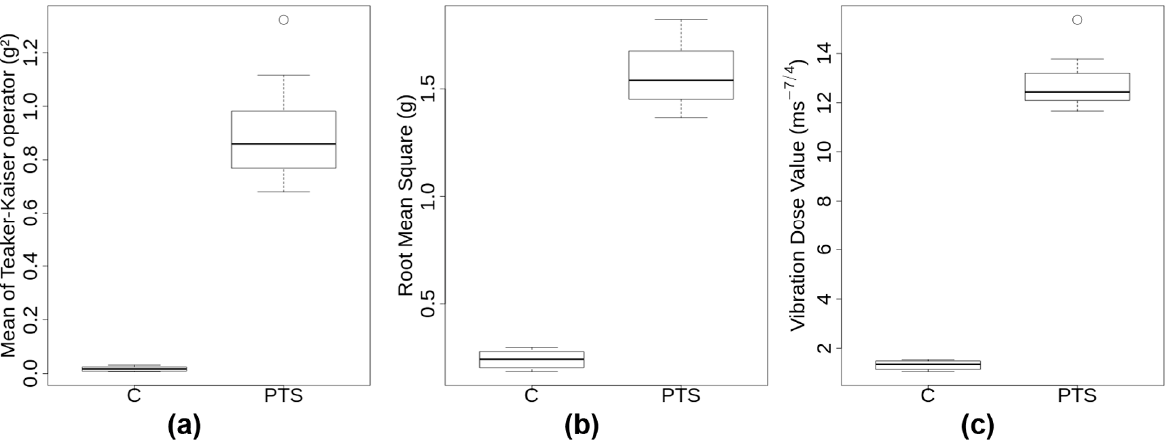
Figure 1. Boxplot representation of the transport metrics. The 12 C values were compared to the 12 PTS values for each transport metrics TK ( a ), RMS ( b ), and VDV ( c ) with C on the left and PTS on the right of each graph. The mean of Teaker–Kaiser operator for C ranged from 0.008 to 0.032 g 2 . All three metrics showed highly significant differences between C and PTS with Welch’s t -test p -values of 3.5 × 10 − 9 for mean of Teaker–Kaiser operator, 1.5 × 10 − 13 for root mean square, and 1.2 × 10 − 13 for vibration dose value, respectively.